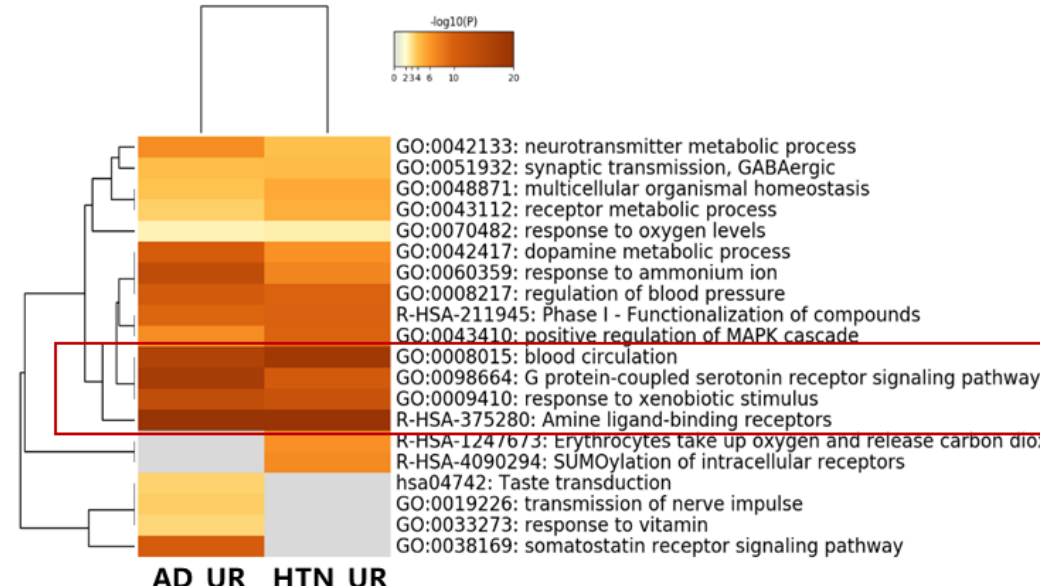
Figure 3. Heatmap of pathway analysis between AD_UR and HTN_UR using Metascape database. Targets in AD_UR and HTN_UR shared important biological processes, such as “amine ligand-biding receptors”, “response to xenobiotic stimulus”, “blood circulation”, and “G protein-coupled serotonin receptor signaling pathway”.